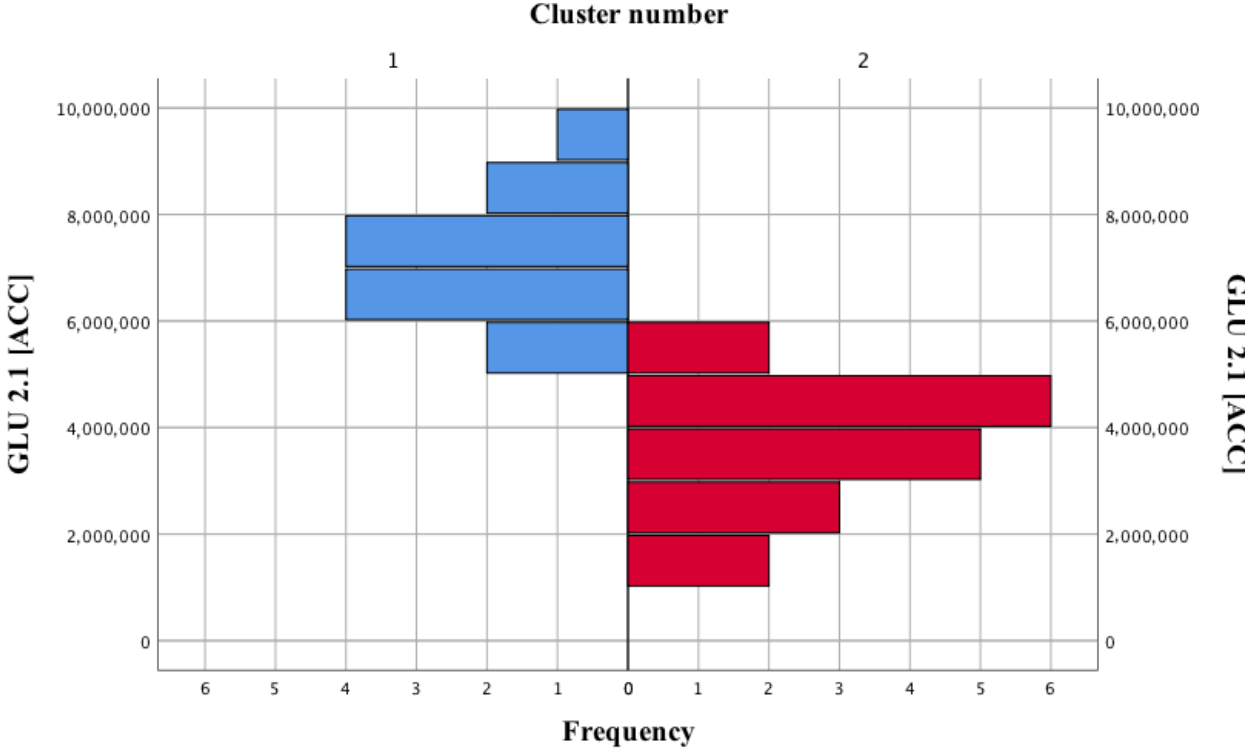
Figure 2. Separated clusters of subjects based on the GLU 2.1 (ACC) level, i.e., differing to the greatest possible extent in terms of the quality of life.